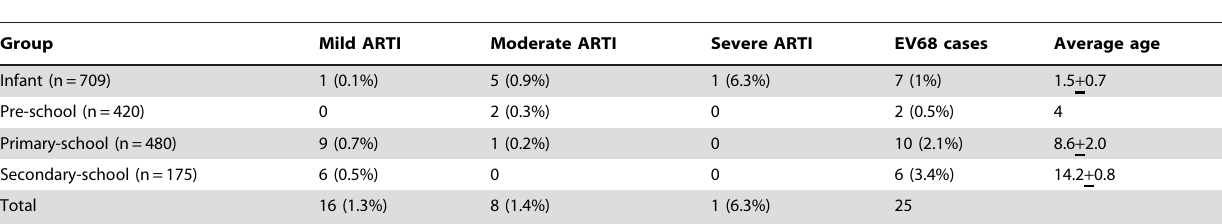
Table 4. ARTI cases infected by EV68 in Thailand from June 2009 to November